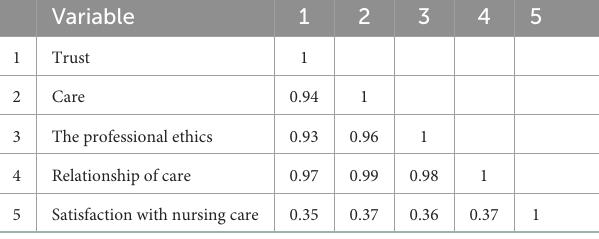
TABLE 2 Correlation between relational care, scores of each dimension and nursing care satisfaction ( n = 29,108).